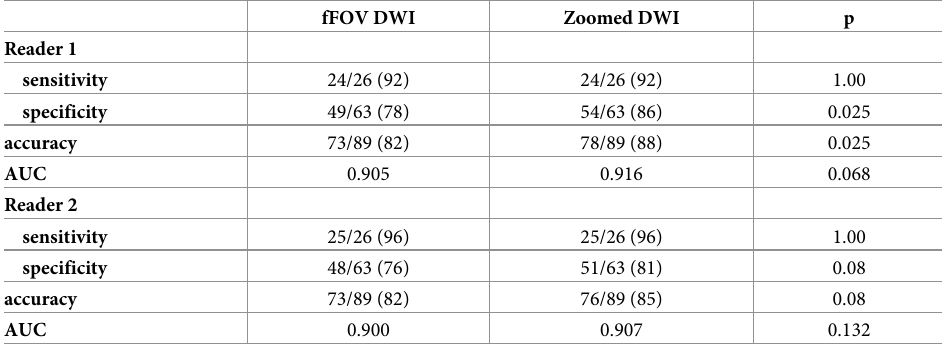
Table 3. Diagnostic abilities of T staging of the bladder cancer.